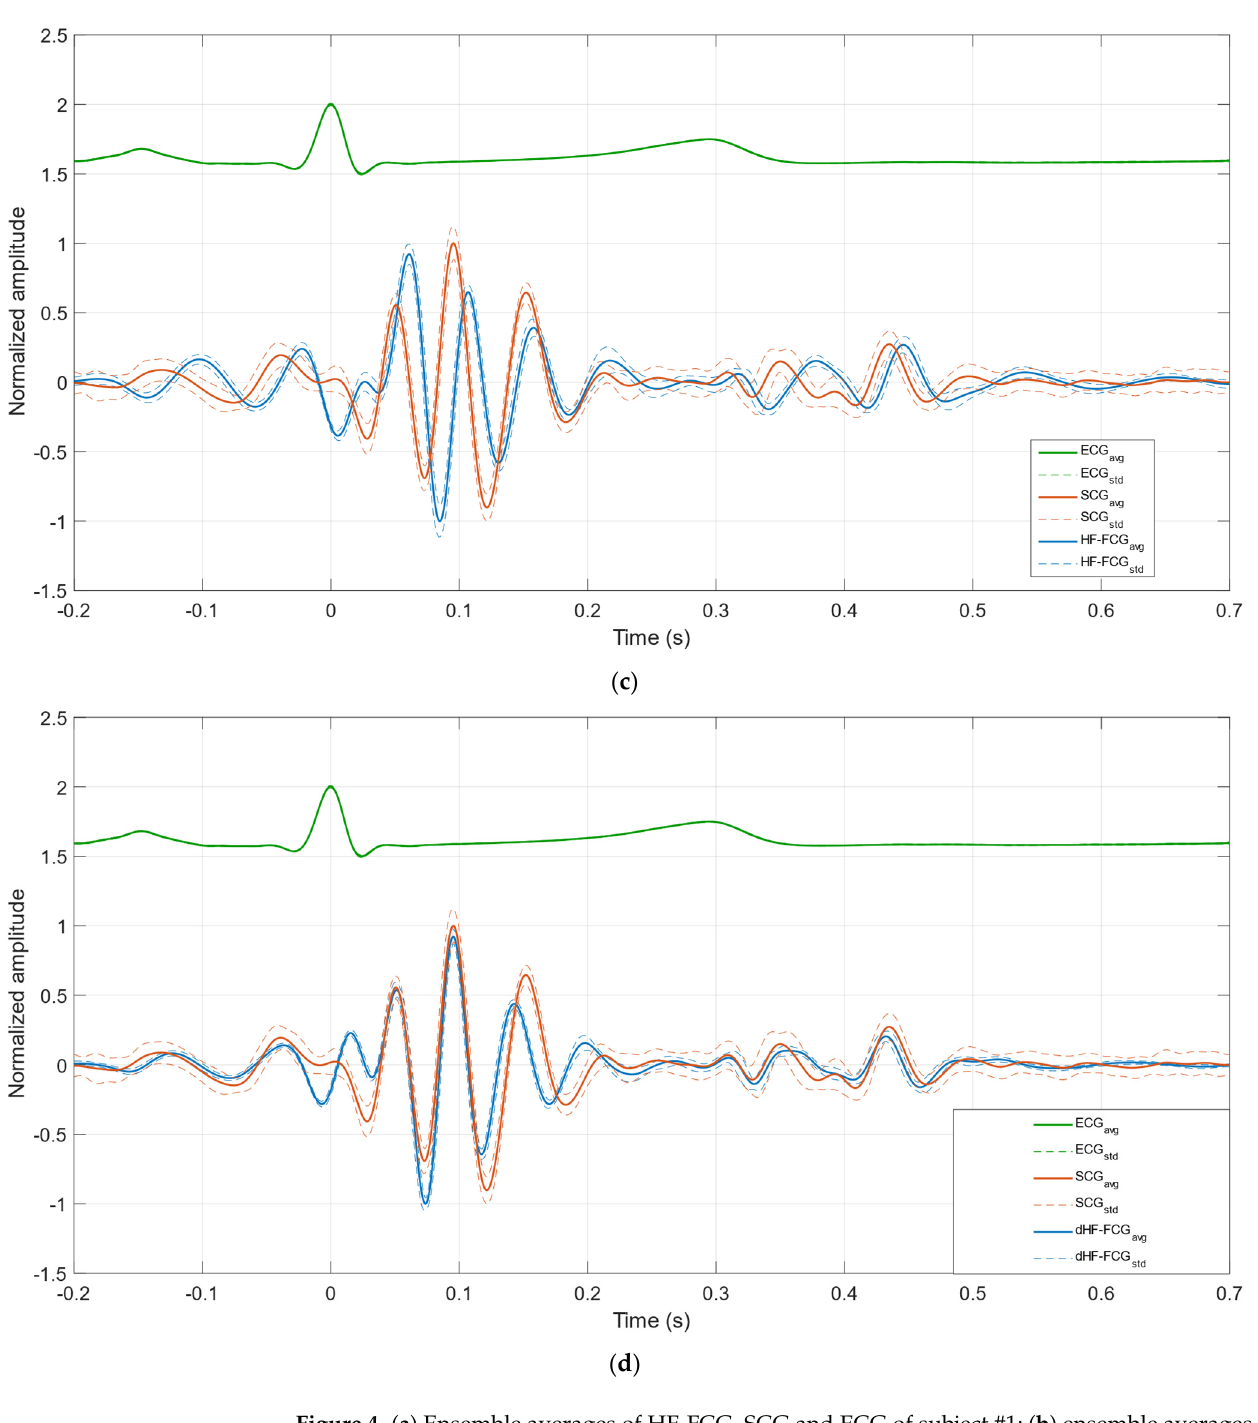
Figure 4. ( a ) Ensemble averages of HF-FCG, SCG and ECG of subject #1; ( b ) ensemble averages of dHF-FCG, SCG and ECG of subject #1; ( c ) ensemble averages of HF-FCG, SCG and ECG of subject #3; ( d ) ensemble averages of dHF-FCG, SCG and ECG of subject #3. The ensemble averages are depicted as solid lines, while the limits of the ±SD ranges are depicted as dashed lines.